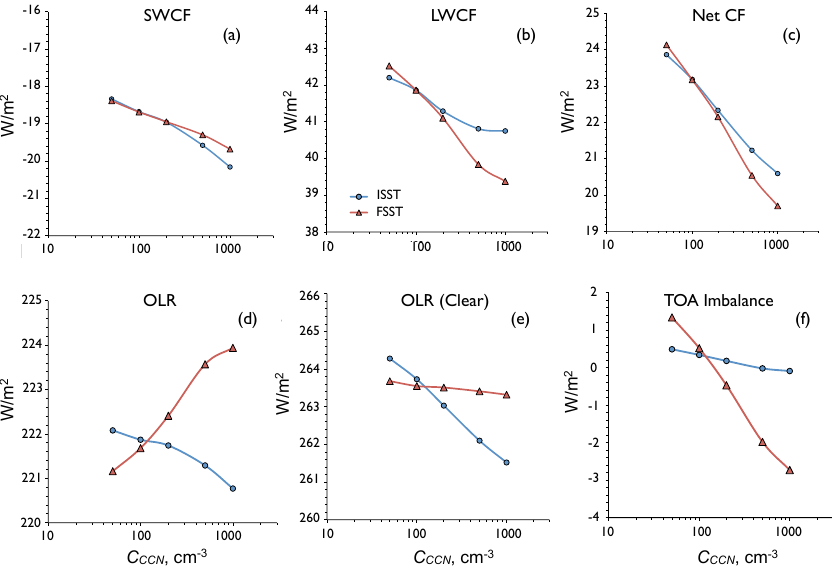
Fig. 3. Dependence of (a) SWCF, (b) LWCF, (c) SWCF + LWCF, (d) all-sky OLR, (e) clear-sky OLR, and (f) TOA radiation imbalance on CCN number concentration at 1% supersaturation in simulations with fixed (red) and interactive (blue) SST.